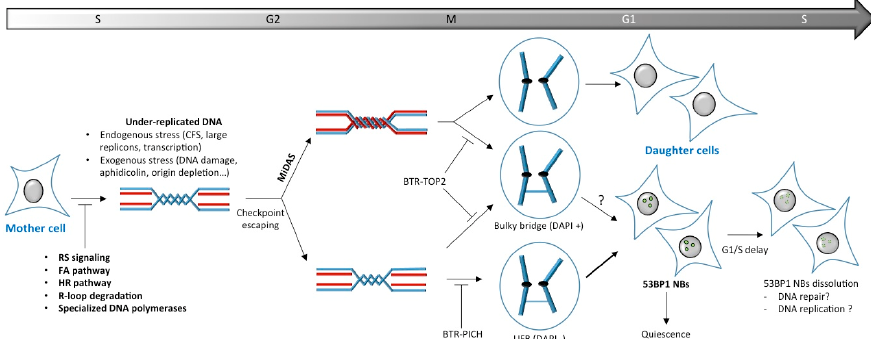
Figure 2. General scheme of 53BP1 NBs formation. During S phase, difficult to replicate loci such as common fragile sites (CFS) and direct DNA damage induce physiological replication stresses